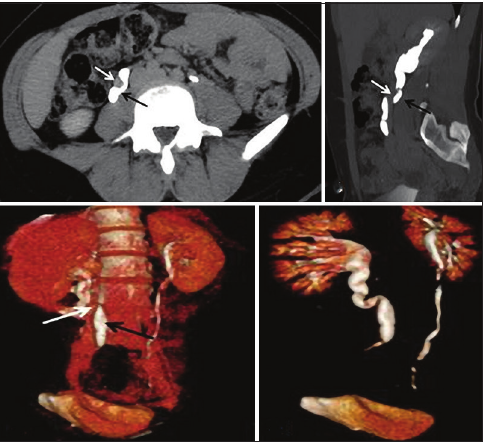
FIGURE 1. In late venous phase contrast-enhanced CT, axial, sagit- tal-oblique maximum intensity projection (MIP), and three dimensional volume rendering (3D-VR) images show the right proximal ureteral compression (black arrow) by the right ovarian vein (white arrow).